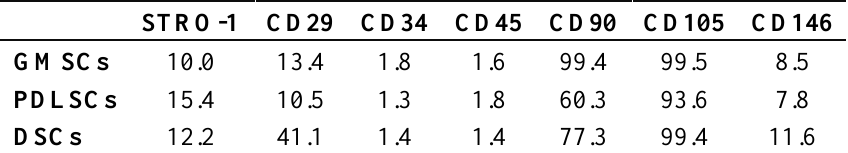
Table 1. The expression levels of the surface markers by GMSCs, PDLSCs and DSCs (P3) determined by flow cytometry.